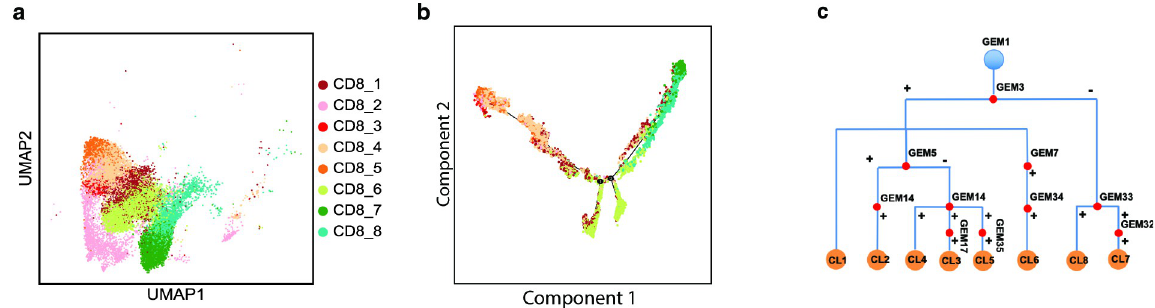
Fig 2. CD8 + T cell subtyping based on GEM compositions. a. UMAP plot of CD8 + T cells. Eight subtypes were identified, which are indicated by pseudo-colors. b. Pseudo-time plot reflecting evolution of subtypes of CD8 + T cells (cell subtype indicated with the same pseudo color scheme as in a ) . c. A hierarchical tree reflecting GEM composition of cell subtypes